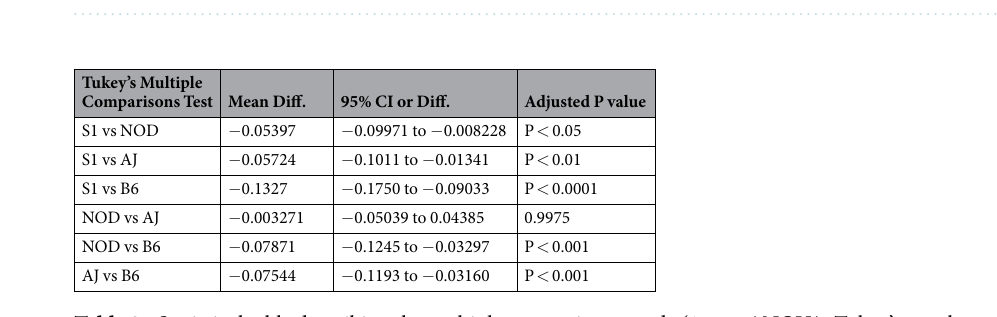
Table 2. Statistical table describing the 2-way ANOVA output and the multiple comparisons made in Fig. 1, panel B, between mouse strains during HCD intake.